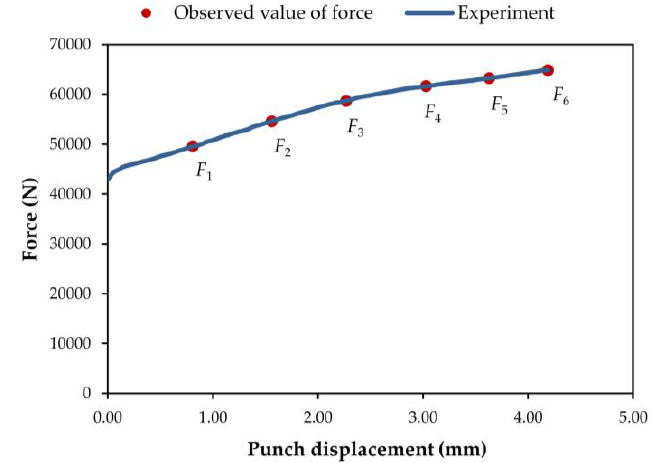
Figure 3. Force—travel diagram.